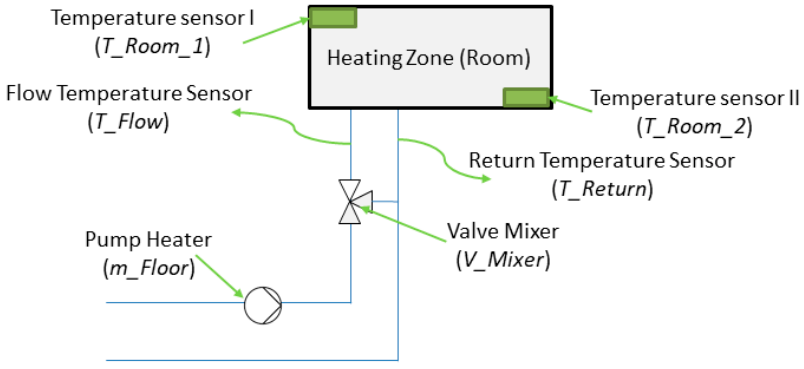
Figure 5. Example of typical sensors and actuators within a heating zone or room.